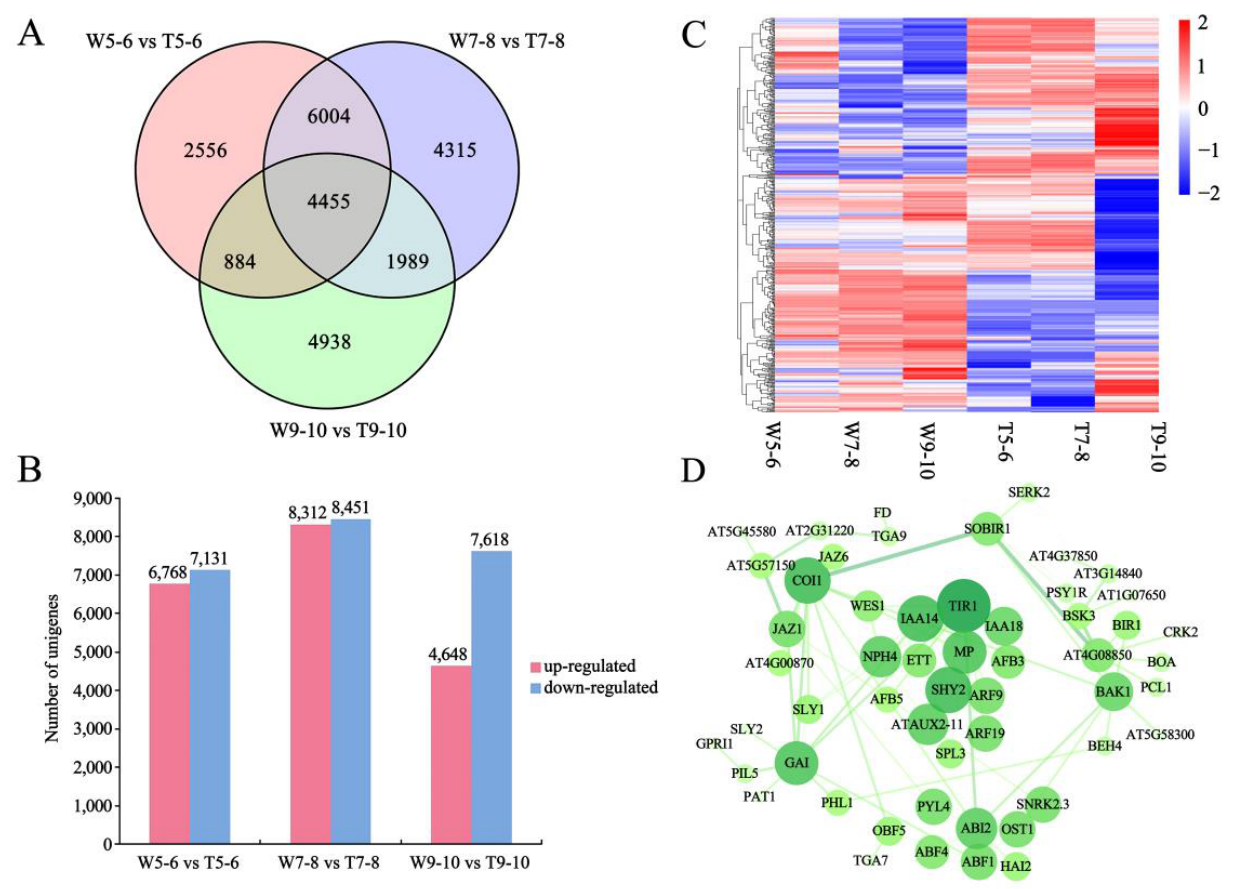
Figure 7. The differentially expressed genes (DEGs) of CVW and CVT at different developmental stages were identified by pairwise comparison. ( A ) A Venn diagram showing the number of DEGs revealed by paired comparison. ( B ) The number of up-regulated and down-regulated DEGs in com- parisons among W5-6_vs._T5-6, W7-8_vs._T7-8, and W9-10_vs._T9-10. ( C ) A heatmap representation of the expression patterns of transcription factors. ( D ) Interaction network prediction of DEGs in plant hormone signal transduction (ko04075) pathway.